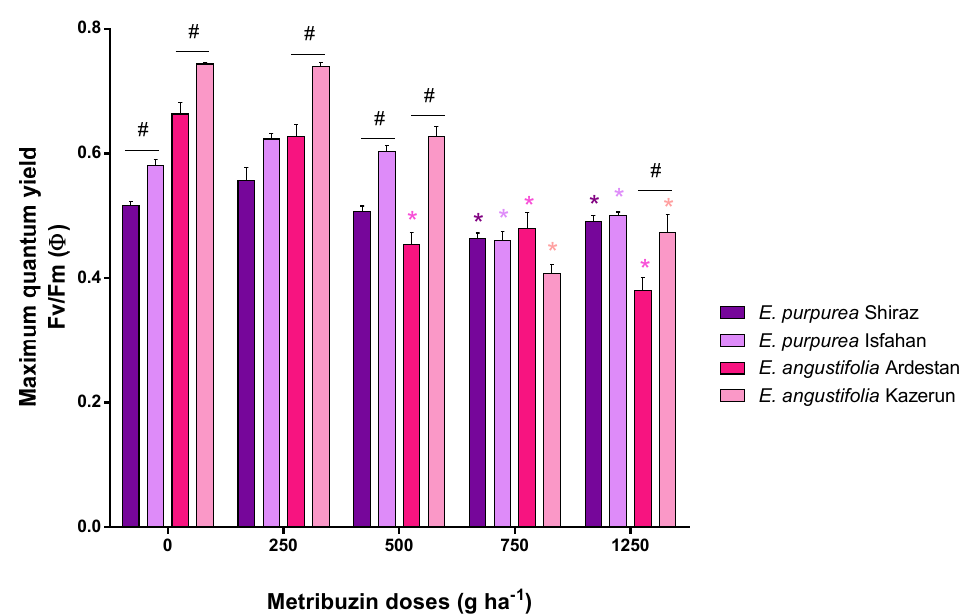
Figure 9. Effect of different metribuzin doses on maximum quantum yield of Echinacea purpurea and Echinacea angustifolia species. Data are shown as the mean ± SEM, and ordinary two-way ANOVA followed by Dunnett’s multiple comparisons test was used for statistical significance; * p < 0.005 vs. control (0 g ha − 1 metribuzin). Significant differences between Echinacea cultivars are indicated with #.